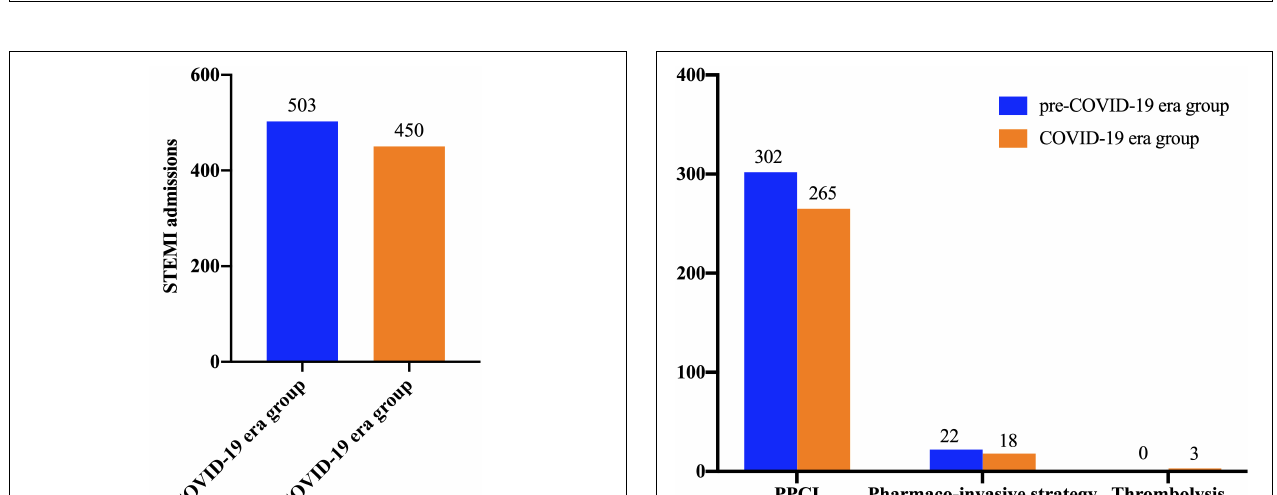
FIGURE 1 | Study flow chart. STEMI, ST-segment elevation myocardial infarction; COVID-19, coronavirus disease 2019; PPCI, primary percutaneous coronary intervention.